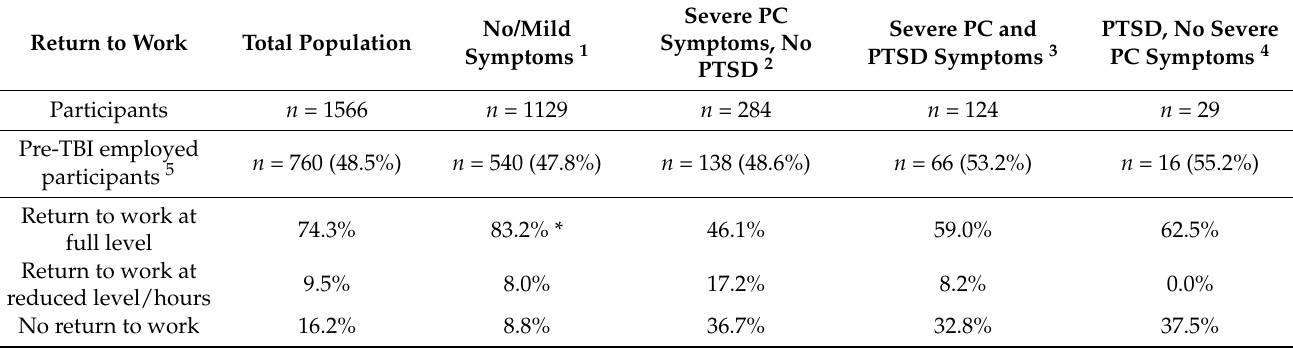
Table 4. Return to work at 6 months post TBI by PC and PTSD symptoms